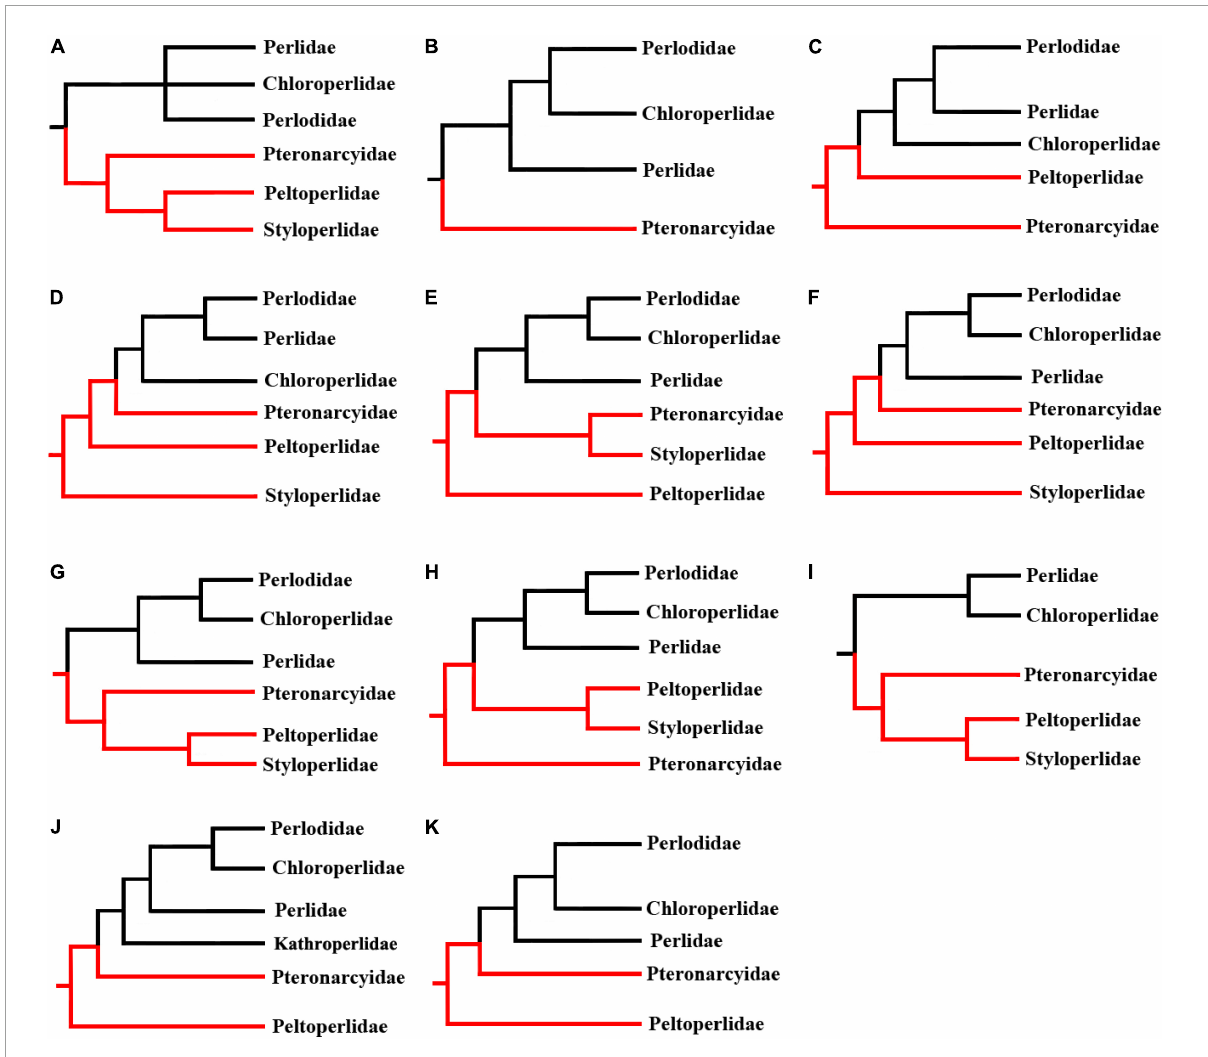
FIGURE1 Representations of previous hypotheses for the family-level relationships within Systellognatha. (A) Zwick (2000), morphological data; (B) Davis (2013), transcriptome data; (C) Thomas et al. (2000), 18S gene; (D) Terry and Whiting (2003), six molecular markers; (E) Chen et al. (2018) and Mo et al. (2022), mitogenome data; (F) Shen and Du (2019) and Veale et al. (2019), mitogenome data; (G) Shen and Du (2020), mitogenome data; (H) Wang et al. (2019), mitogenome data; (I) Wang et al. (2018) and Ding et al. (2019), mitogenome data; (J) South et al. (2021a), transcriptome data; (K) South et al. (2021b), transcriptome data (concatenated complete nucleotide data set). Clades with black and red color belong to the superfamily Perloidea and Pteronarcyoidea, respectively.